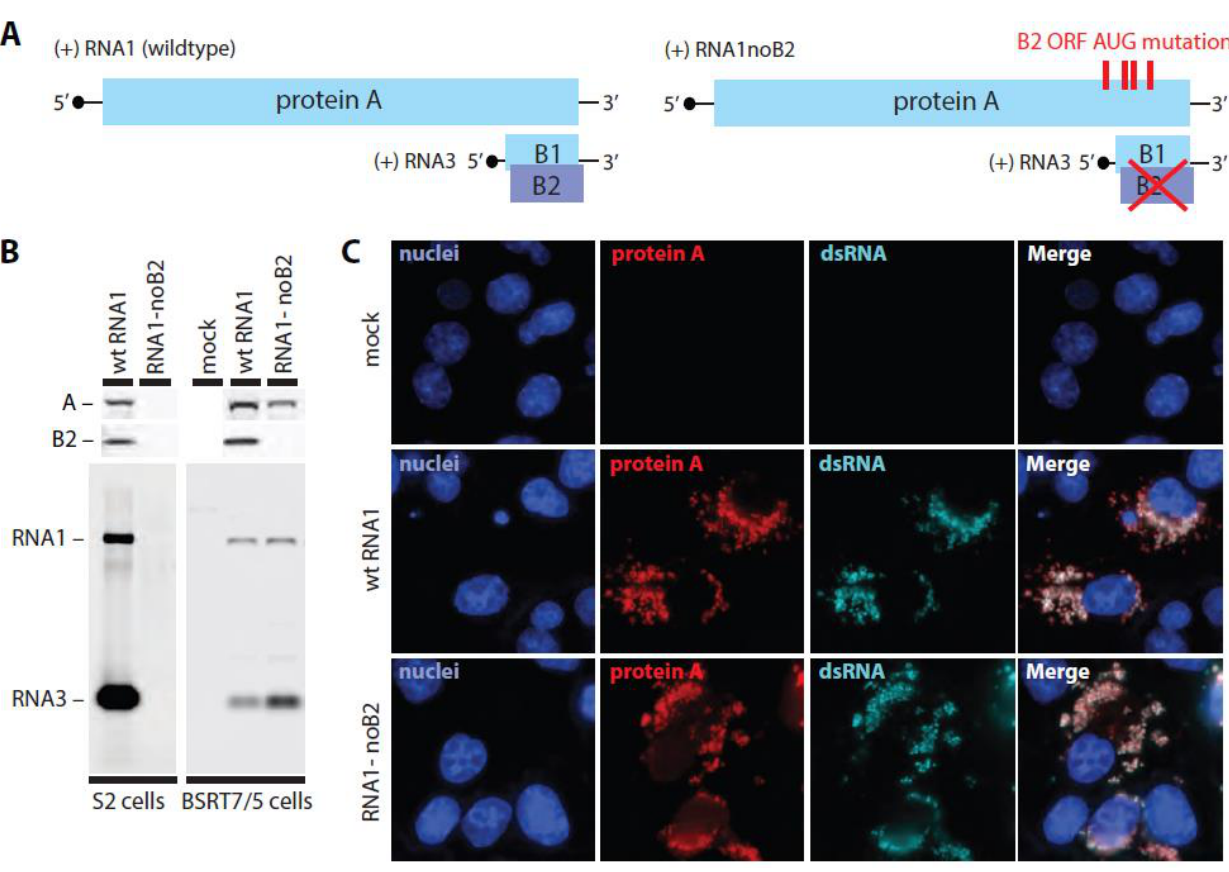
Figure 4. Analysis of the replication of wt FHV RNA1 and its mutant derivative RNA1-noB2 replication in insect and mammalian cells. ( A ) Schematic maps of wildtype RNA1 and an RNA1-derivative that lacks coding potential for B2 due to mutations of initiator and downstream methionine codons that are silent in the -1 frame encoding protein A sequence. ( B ) B2 is a strong suppressor of RNA-interference (RNAi), and RNA1-noB2 does not support stable accumulation of RNA1 and subgenomic RNA3 and protein A in Drosophila S2 cells that have a strong antiviral RNAi response (left lanes). By contrast, RNA1-noB2 launches RNA1 and RNA3 replication levels very similar to wildtype RNA1 in mammalian BSRT7/5 cells that do not display robust RNAi action (right lanes). ( C ) Fluorescence images of BSRT7/5 cells confirm accordingly that B2 is not needed and show that protein A and dsRNA replication intermediates are observed at the mitochondria of wildtype RNA1 and RNA1-noB2 transfected cells at similar levels and distribution.